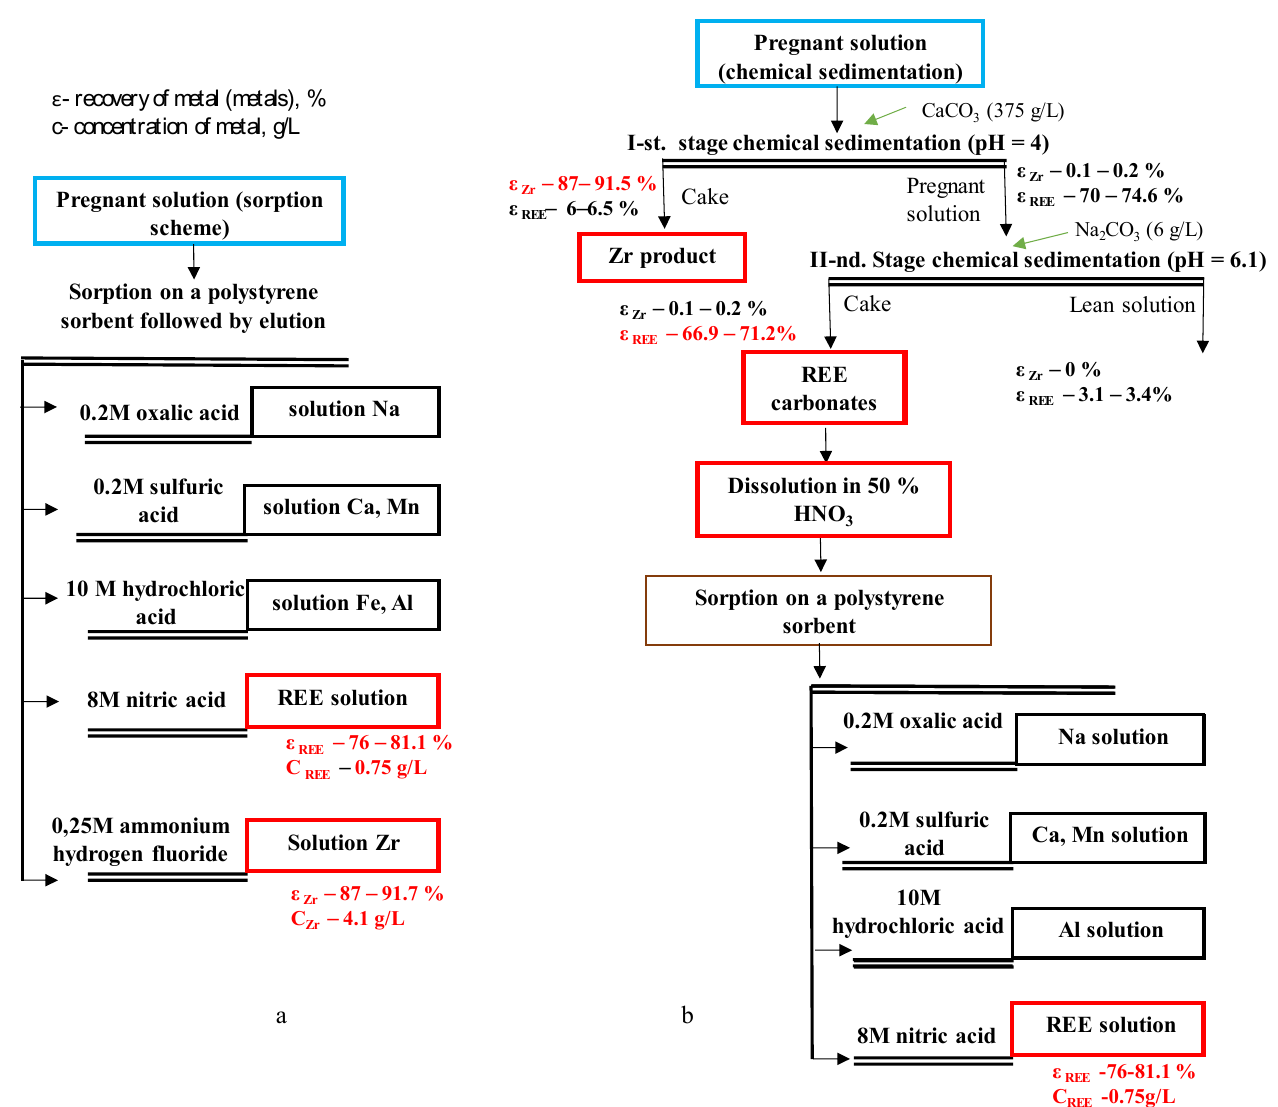
Figure 12. Schemes of the REE recovery from pregnant leaching solution through sorption ( a ) and precipitation-sorption schemes ( b ).